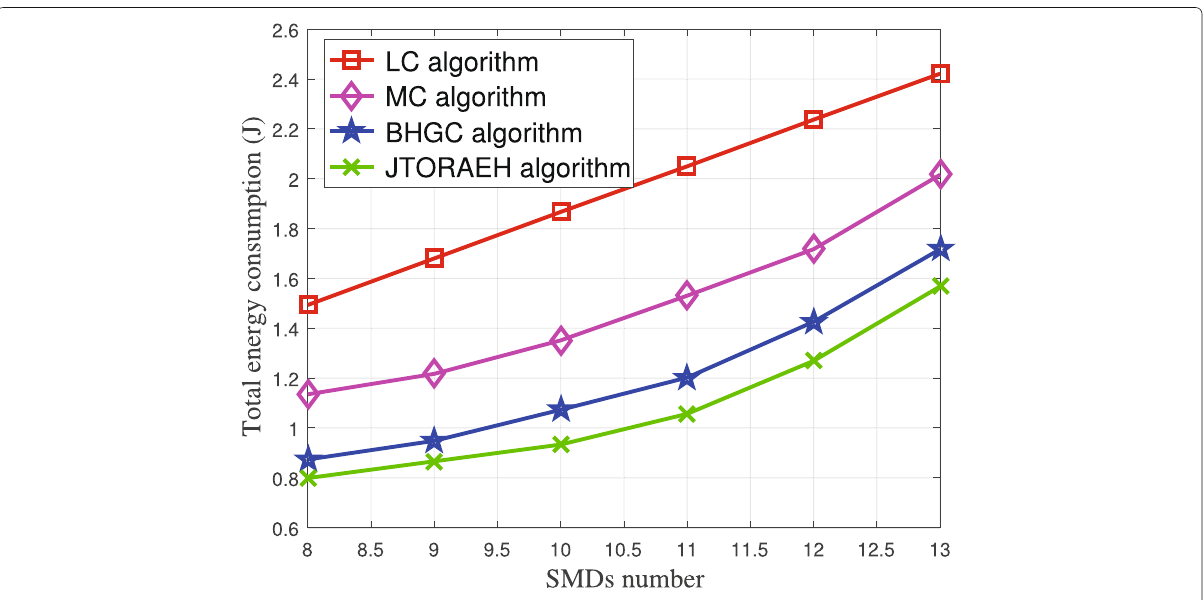
Fig. 6 Total energy consumption versus SMDs number